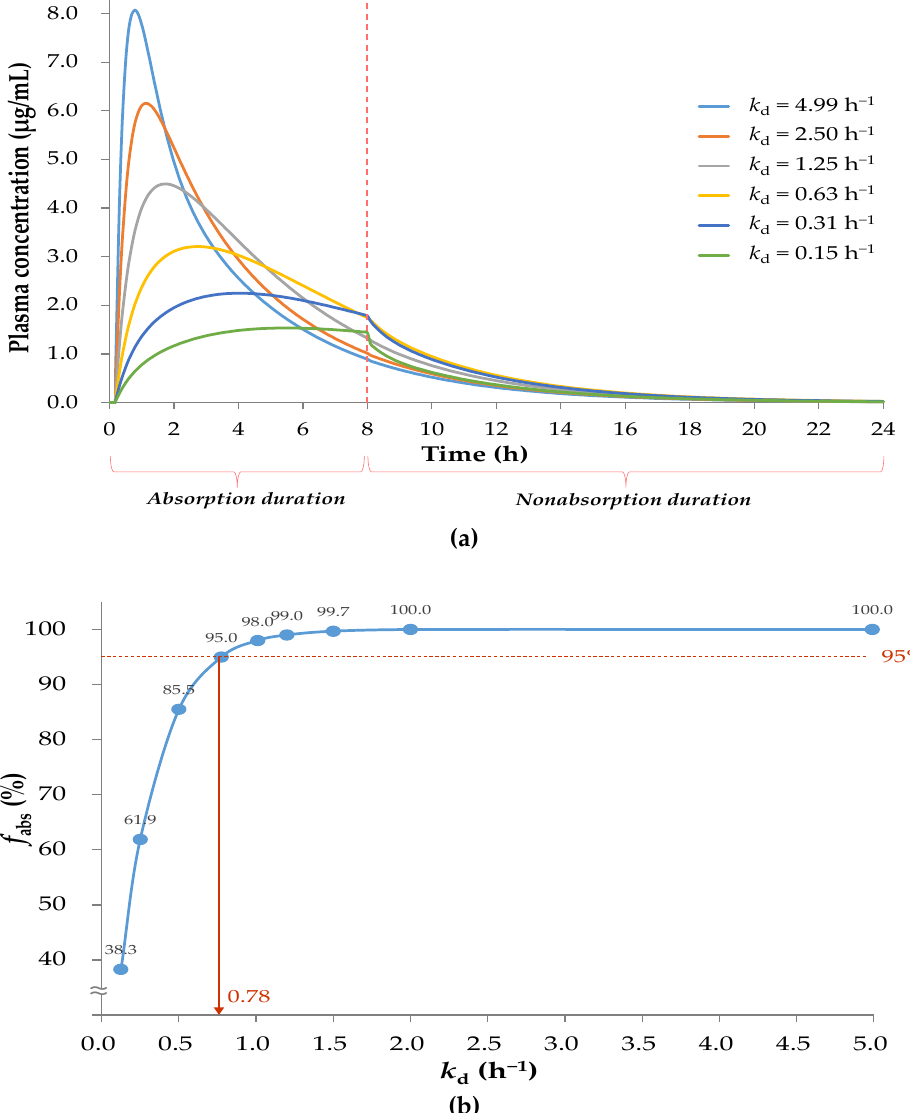
Figure 4. ( a ) Simulation of sobrerol oral pharmacokinetic profiles with various k d values in consid- eration of gastrointestinal transit time of 8 h; ( b ) The correlation of f abs at 24 h with corresponding k d . In case of the f abs is >95% by 24 h, the k d should not be <0.78 h − 1 .